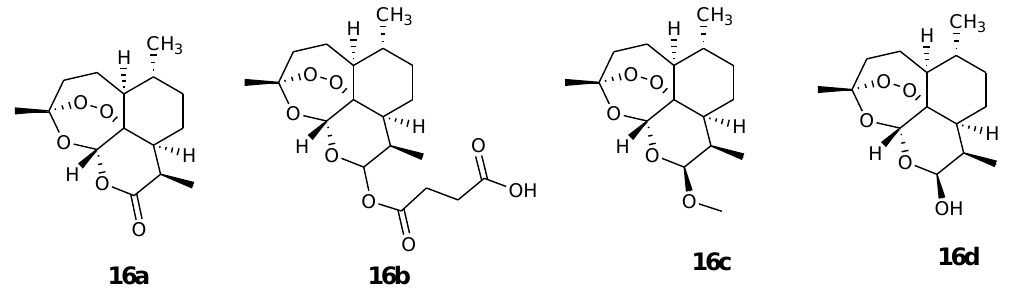
Figure 6. Artemisinin and its derivatives.